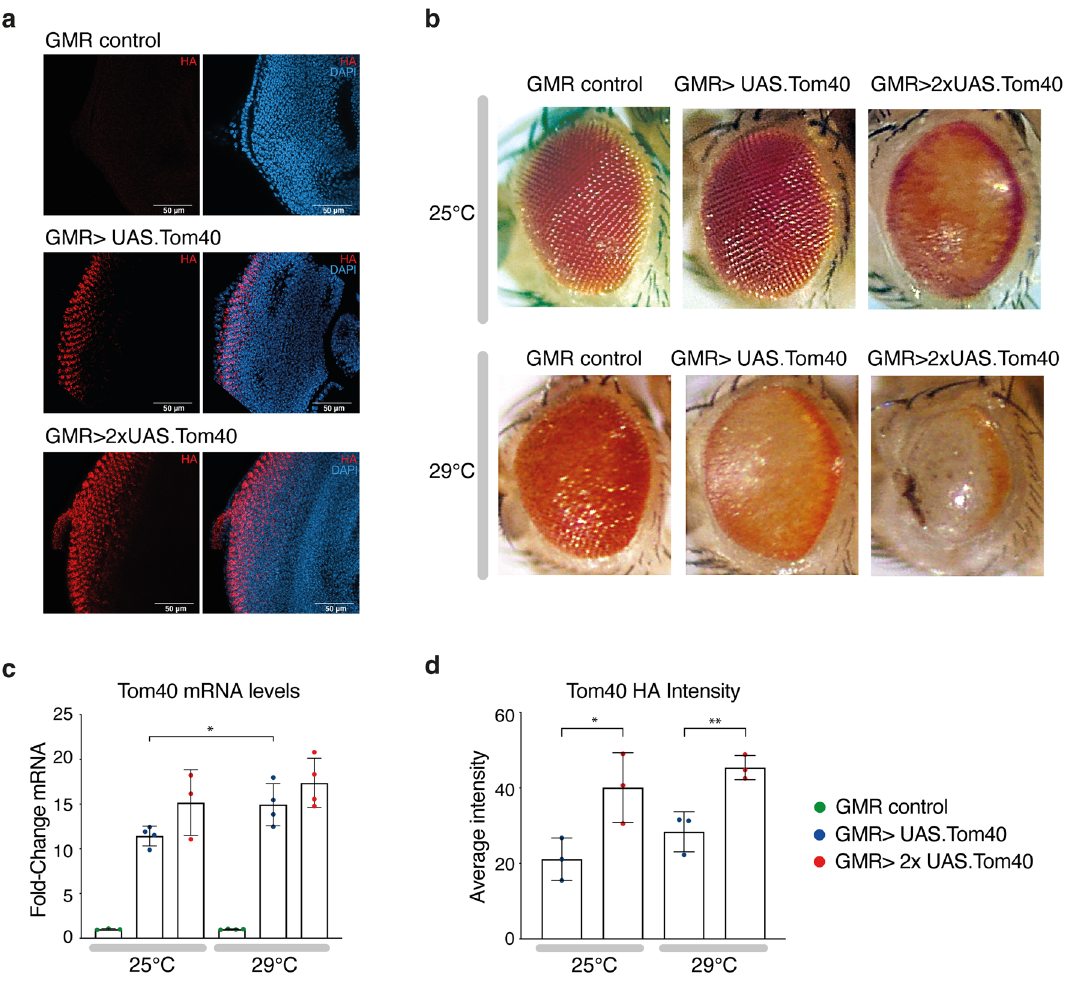
Figure 1. Tom40 overexpression causes eye degeneration. ( a ) Confocal microscopy of immunofluorescence staining for Tom40 overexpression in imaginal eye discs of third instar Drosophila larvae (control GMR-GAL4, single-copy UAS.Tom40 and double-copy UAS.Tom40 ) stained with HA antibody (red) against the epitope tag and DAPI (blue) for DNA/nuclei. ( b ) Representative images of adult eyes for genotypes as labelled. Rearing temperature is as indicated. For each genotype, 8–10 flies were imaged using light microscopy. ( c ) Quantification of total Tom40 abundance in Drosophila third instar larval eye discs at 25 °C and 29 °C with 1 or 2 copies of the Tom40 gene, as assessed by qPCR, normalised to a driver-only control. Data are represented as mean ± SD from three or four independent experiments (p value = 0.0359 by unpaired t-test). The colour coding is the same in panels ( c ) and ( d ). Asterisks indicate p-values ≤ 0.05 by t-test. ( d ) Relative Tom40 expression based on intensity of HA staining (n = 3 for each column from independent eye discs) * denotes p = 0.0384, ** denotes p = 0.0089 using unpaired